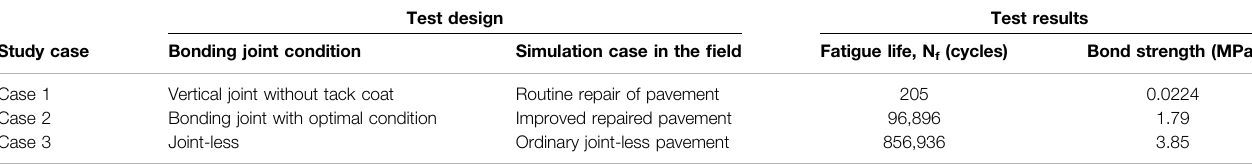
TABLE 7 | The different performances of the pavement before and after repair of